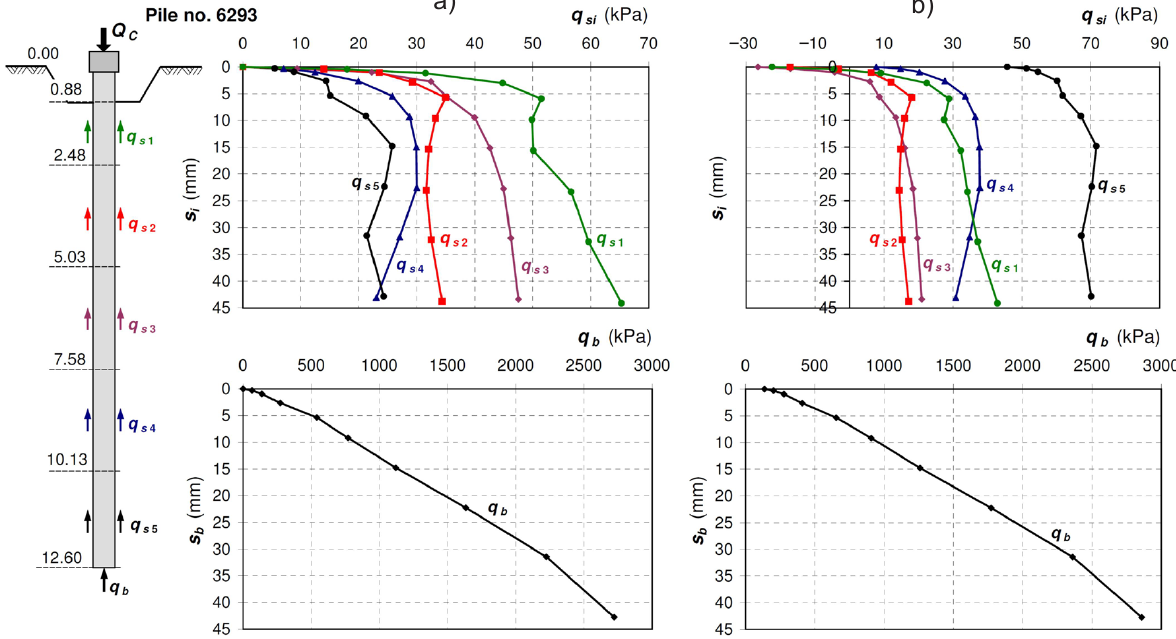
and q unit soil resistances around the pile for the cases: a) without taking into account the s b